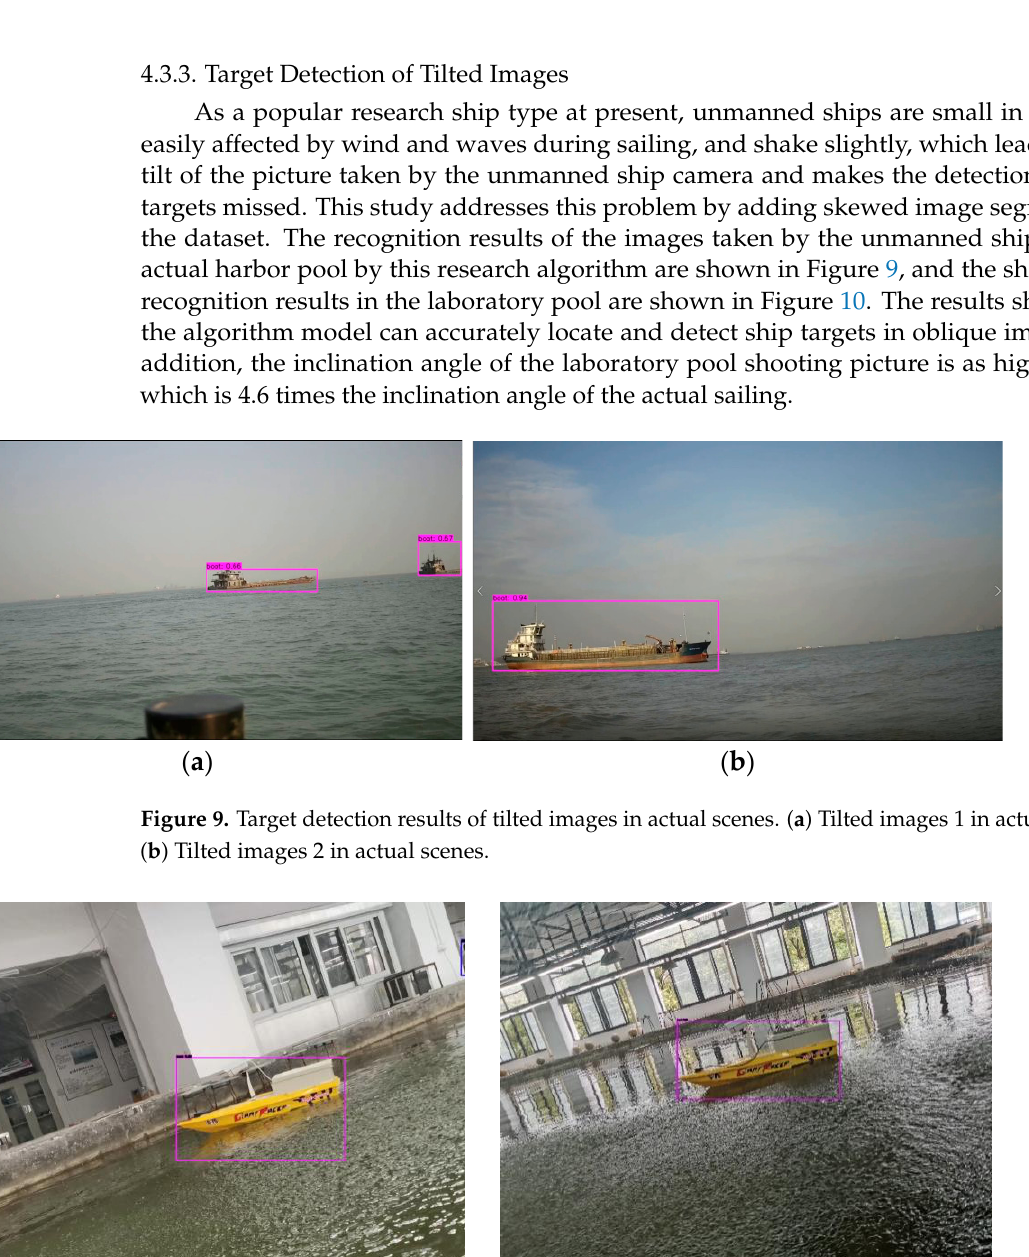
( d ) Figure 8. Target detection results under background interference in experimental pool. ( a ) Ship tar-